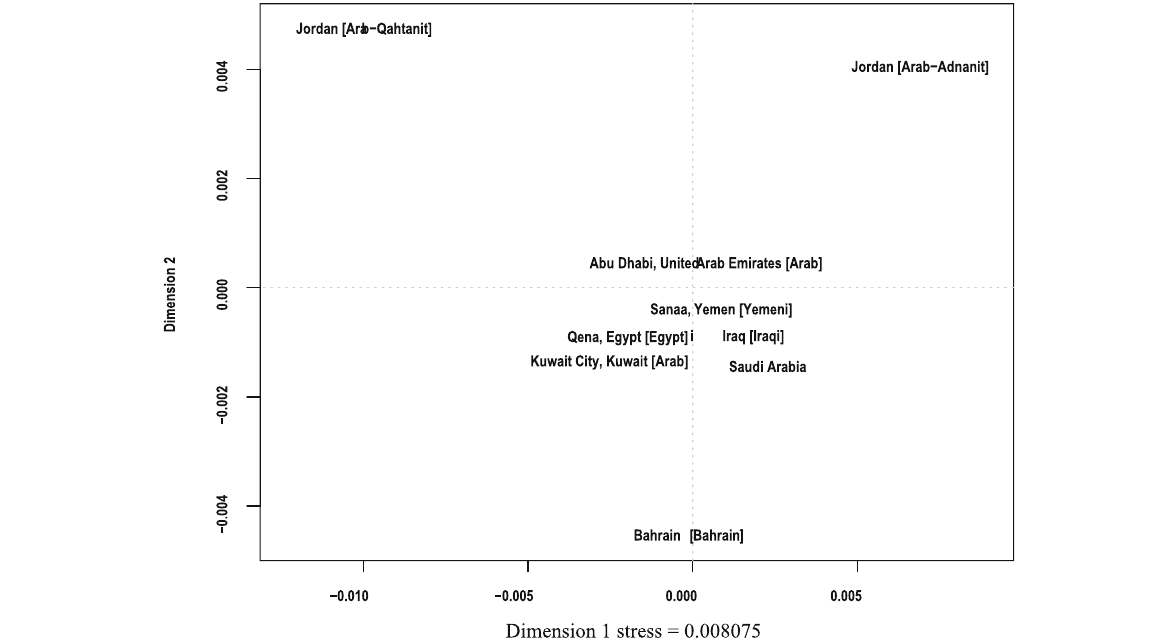
Fig. 3 Multidimensional scaling (MSD) based on pairwise R ST genetic distances of native Saudi populations and seven other neighboring Arab populations (Egypt, Iraq, Jordan, UAE, Yemen, Kuwait, and